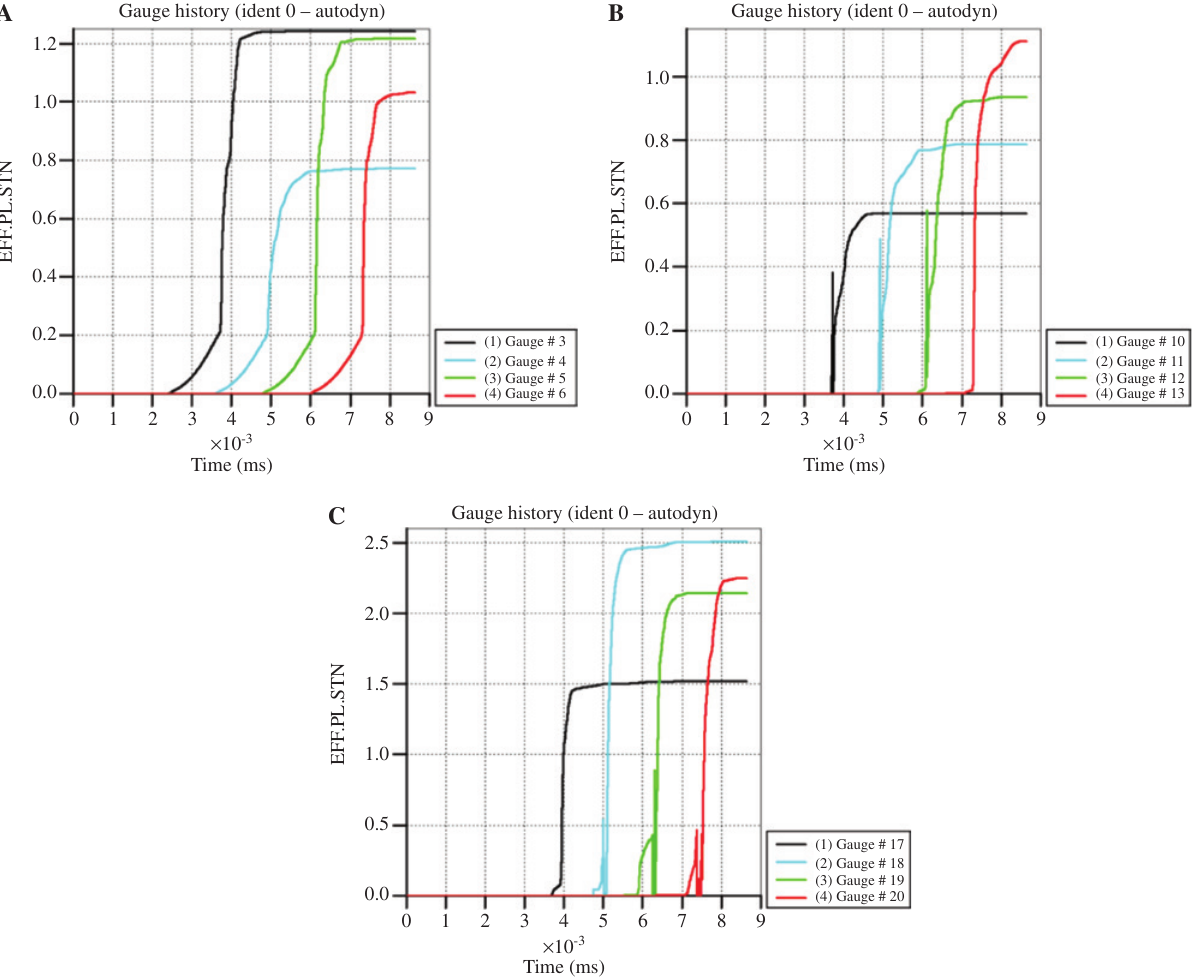
Figure 12: Effective plastic strain-time curve along the direction of propagation of detonation: (A) the upper surface of aluminum alloy plate; (B) the lower surface of aluminum alloy plate; (C) the upper surface of the magnesium alloy plate.